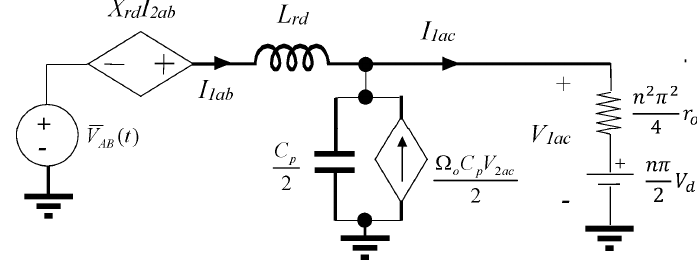
Figure 7. Real part of the large-signal reduced-order envelope model of the inverter stage.